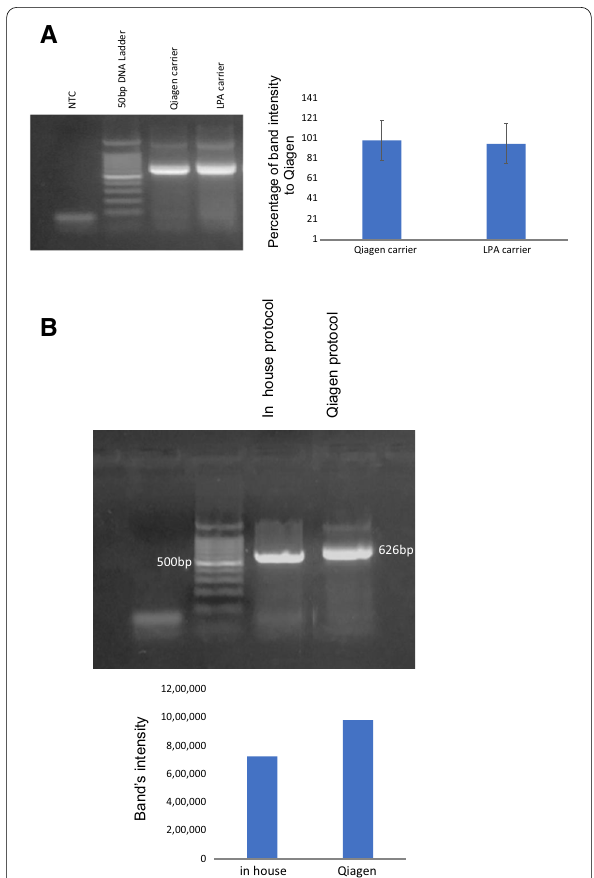
Fig. 3 Evaluation of LPA carrier versus Qiagen carrier. RNA was purified from infected Vero cells with measles virus. The same amount of cells used as startup point to compare Qiagen carrier and LPA carrier using all Qiagen reagents (i.e. the only difference between the tubes is type of carrier). A RT-PCR of N-450 using MeV210 and MeV217 primers for RNA purified with Qiagen reagents and LPA carrier. The samples were compared to whole Qiagen setting control with their carrier by running on 2%Agarose with histogram showing percentage of bands intensities comparable to Qiagen kit. B RT-PCR of N-450 using MeV210 and MeV217 primers for RNA purified with in-house protocol comparable to Qiagen QIAamp viral RNA mini